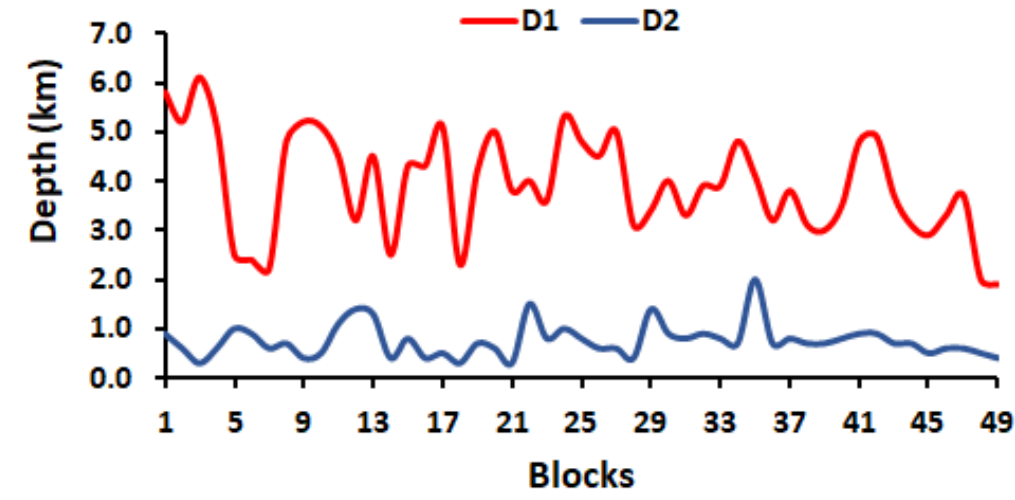
Figure 10. Depth variations across the study area, for the blocks displayed in Figure 5a. D1 and D2 represent deep and shallow depths to magnetic sources. The deeper depths are assumed to coincide with the top of the basement, while the shallower depths probably emanate from intrusives and other intrasedimentary sources.